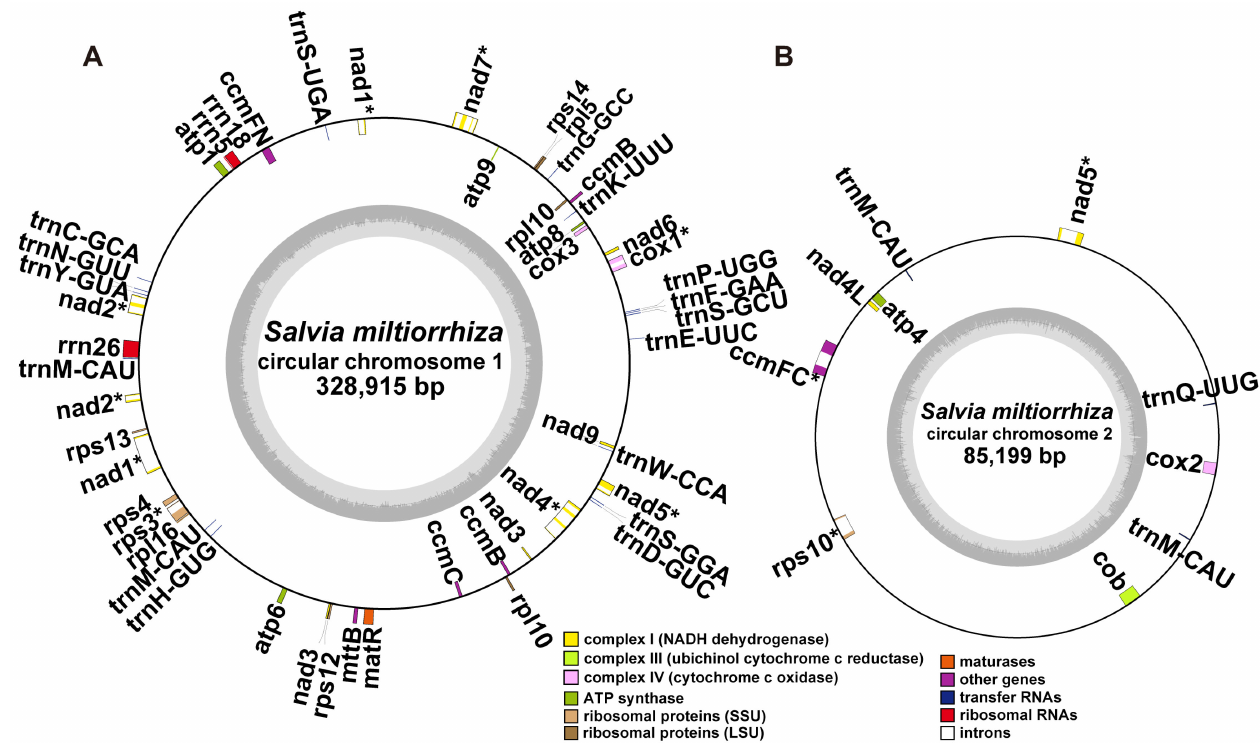
Figure 2. Schematic of the circular MC1 ( A ) and MC2 ( B ) of S. miltiorrhiza . The graph was drawn using PMGView (http://www.1kmpg.cn/pmgview (accessed on 26 June 2022)). Genes shown on the inside were on the negative strand, whereas those on the outside were on the positive strand. Genes with introns were highlighted using “*”. The gray circle represents the GC contents. The circle inside the GC content graph marks the 50% threshold. The colors indicate different functional categories shown in the